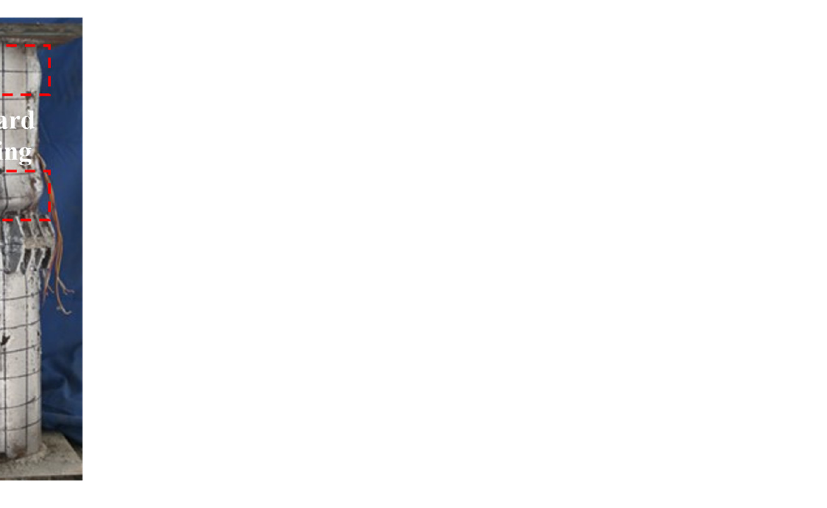
Figure 5. Failure mode of BWCFST short column specimen without imperfection.